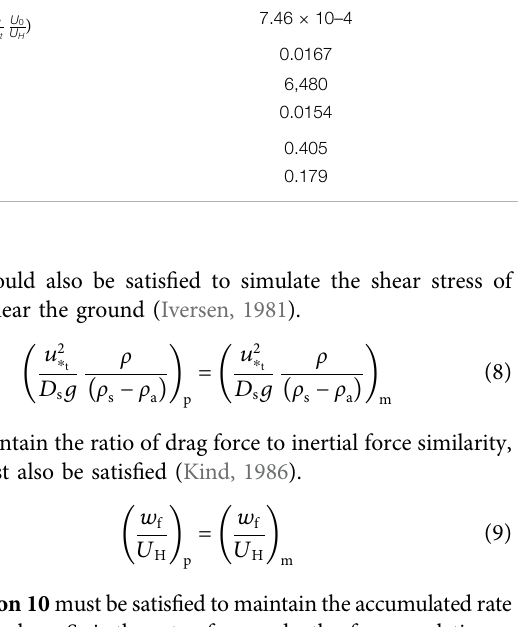
TABLE 4 | Comparison of similarity criteria of self-test prototype and multidimensional scale models. Similarity parameters